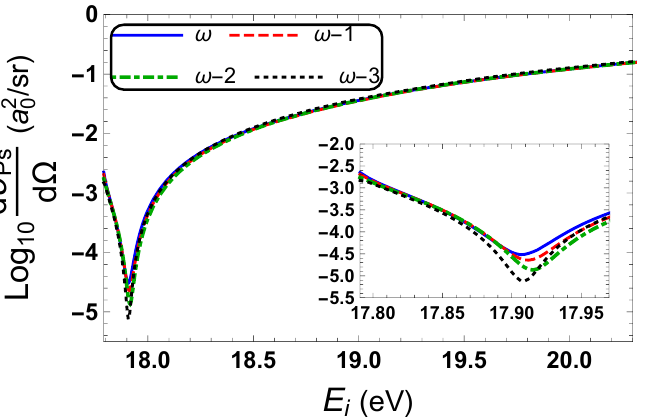
[ DCS ] , as a 10 [ DCS ] for a fine energy mesh in the vicinity of 10